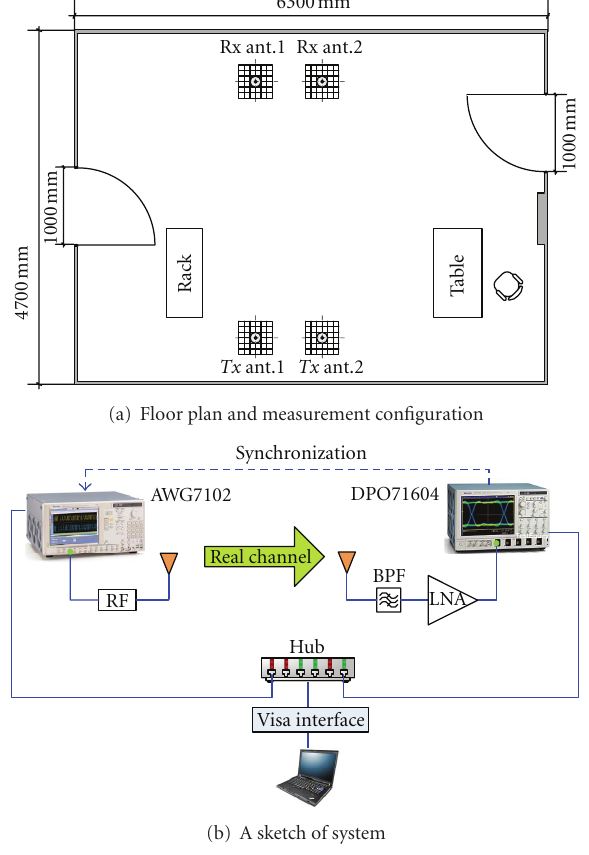
Figure 2: Setup of UWB channel measurement.